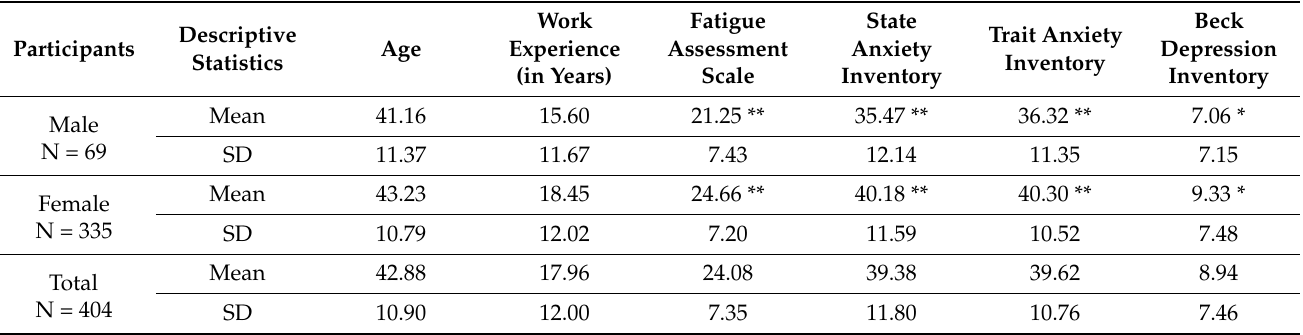
Table 1. General characteristics of nursing staff and fatigue/anxiety/depression scores with regards to